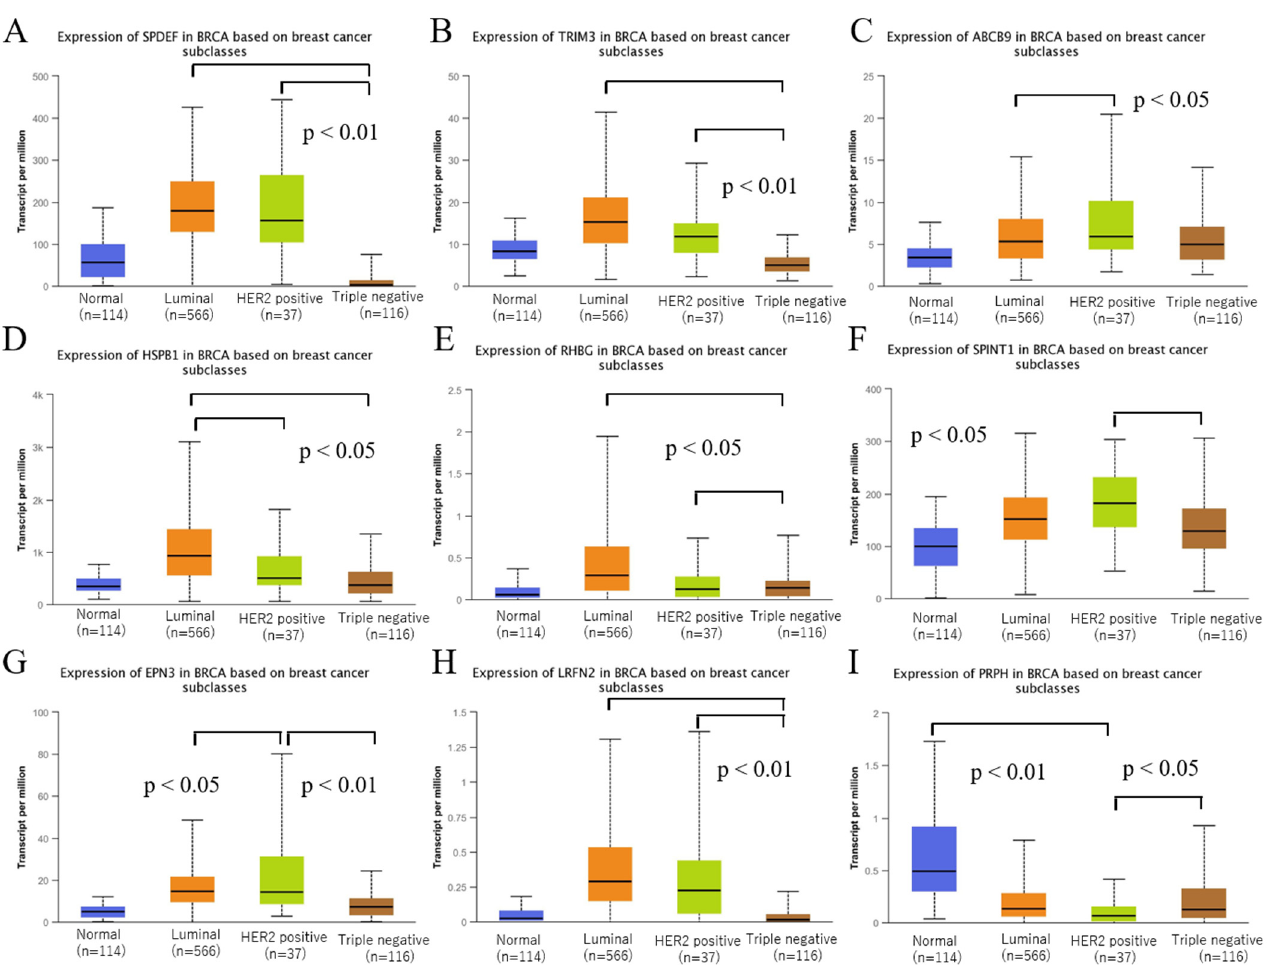
Figure 5. Validation of the expression of genes in the intrinsic subtype of TCGA_BRCA in UALCAN. ( A ) SPDEF , ( B ) TRIM3 , ( C ) ABCB9 , ( D ) HSPB1 , ( E ) RHBG , ( F ) SPINT1 , ( G ) EPN3 , ( H ) LRFN2 , and ( I ) PRPH .